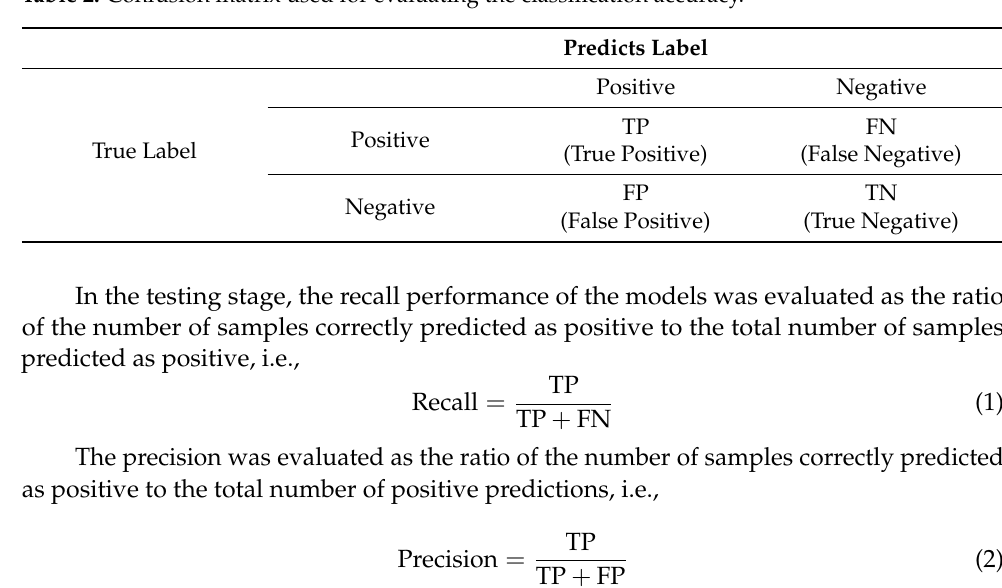
Table 2. Confusion matrix used for evaluating the classification